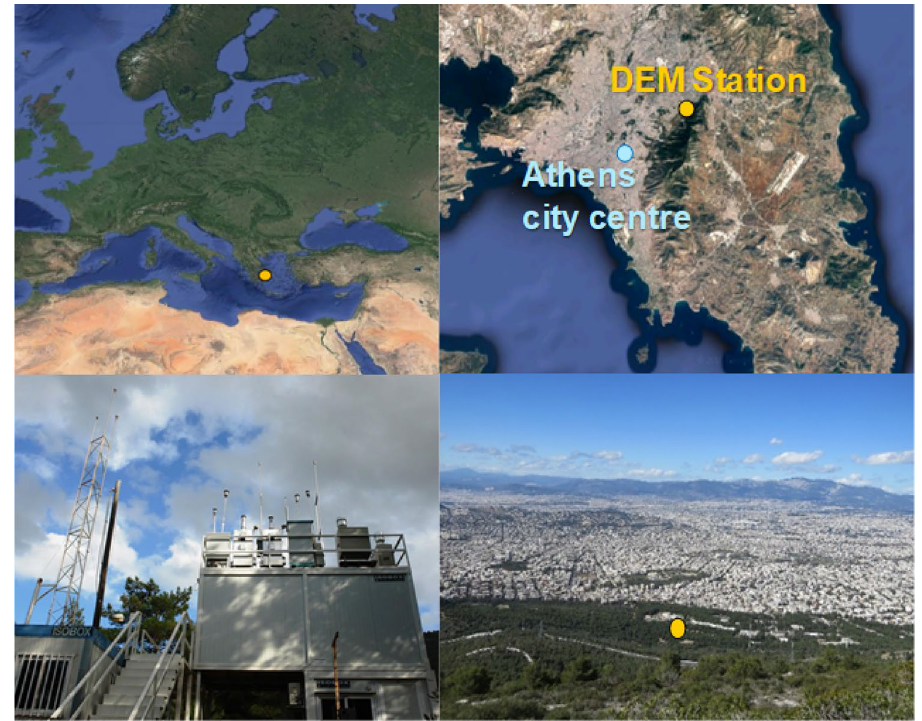
Figure 1. The Demokritos Atmospheric Aerosol Measurement station in Ag. Paraskevi, Athens, Greece, DEM (GAW, ACTRIS). The maps were obtained from Google Maps (maps.google.com) Imagery 2021 Terrametrics, Mapdata 2021 and modified by the